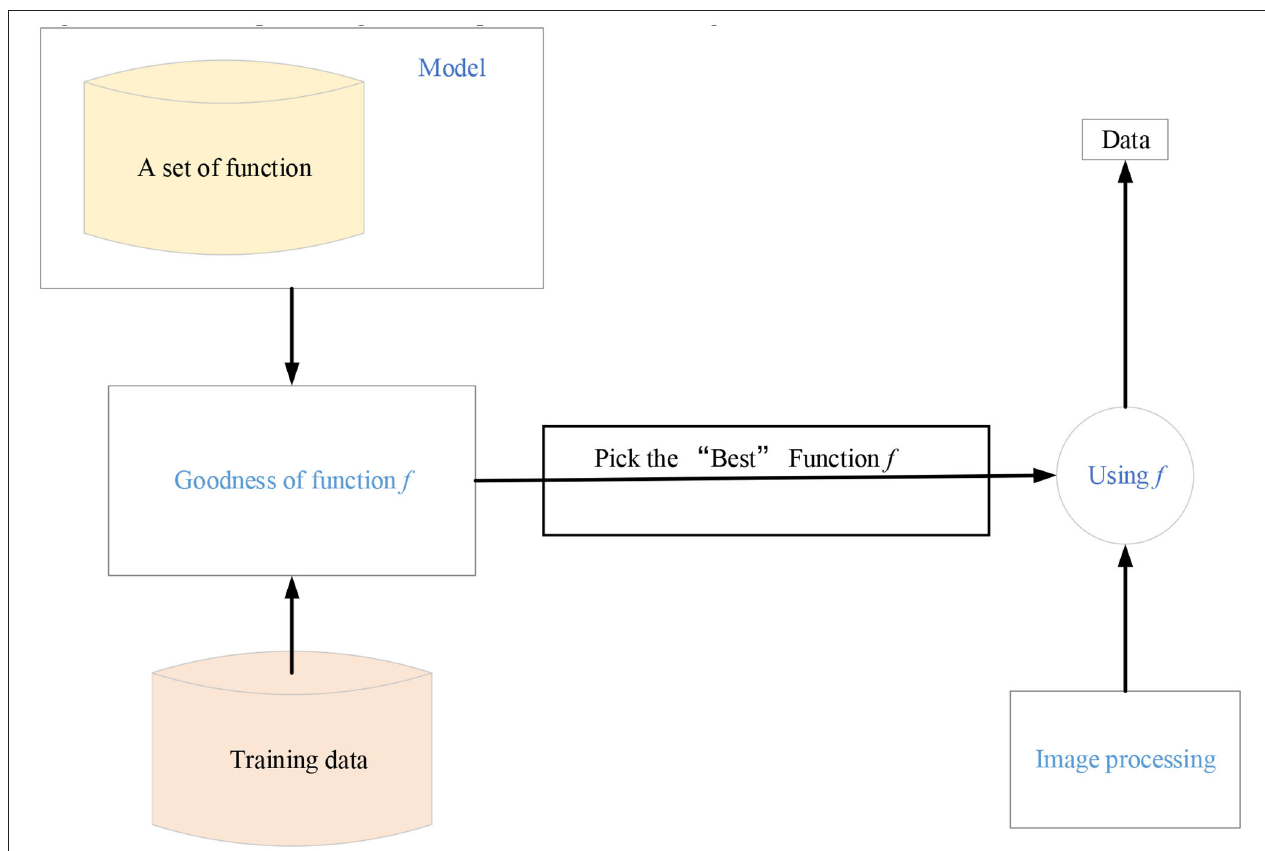
FIGURE 1 | Machine learning